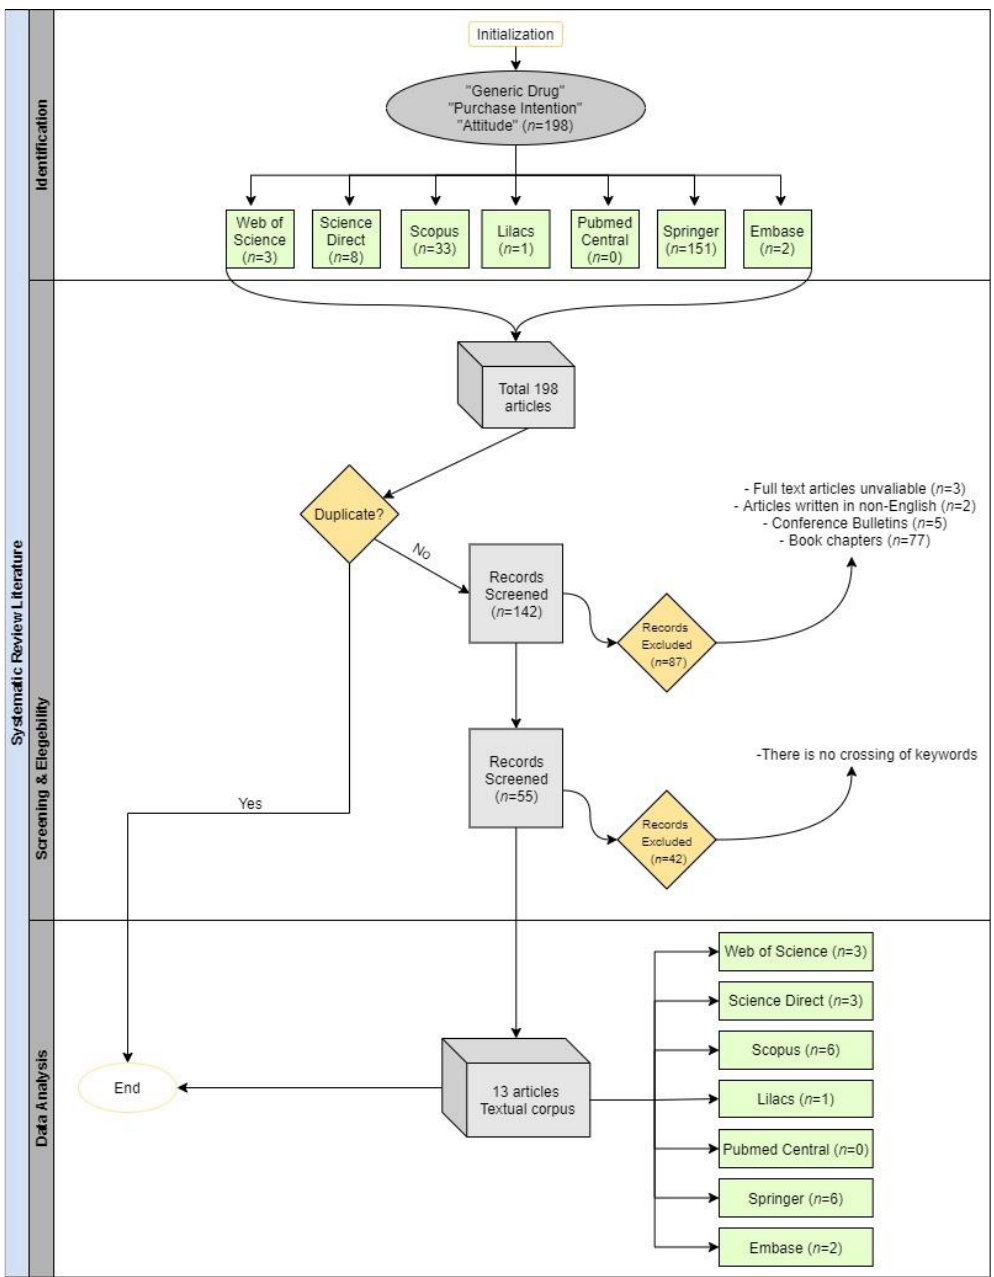
Figure 1. Flowchart of the study selection process following PRISMA guidelines [46].